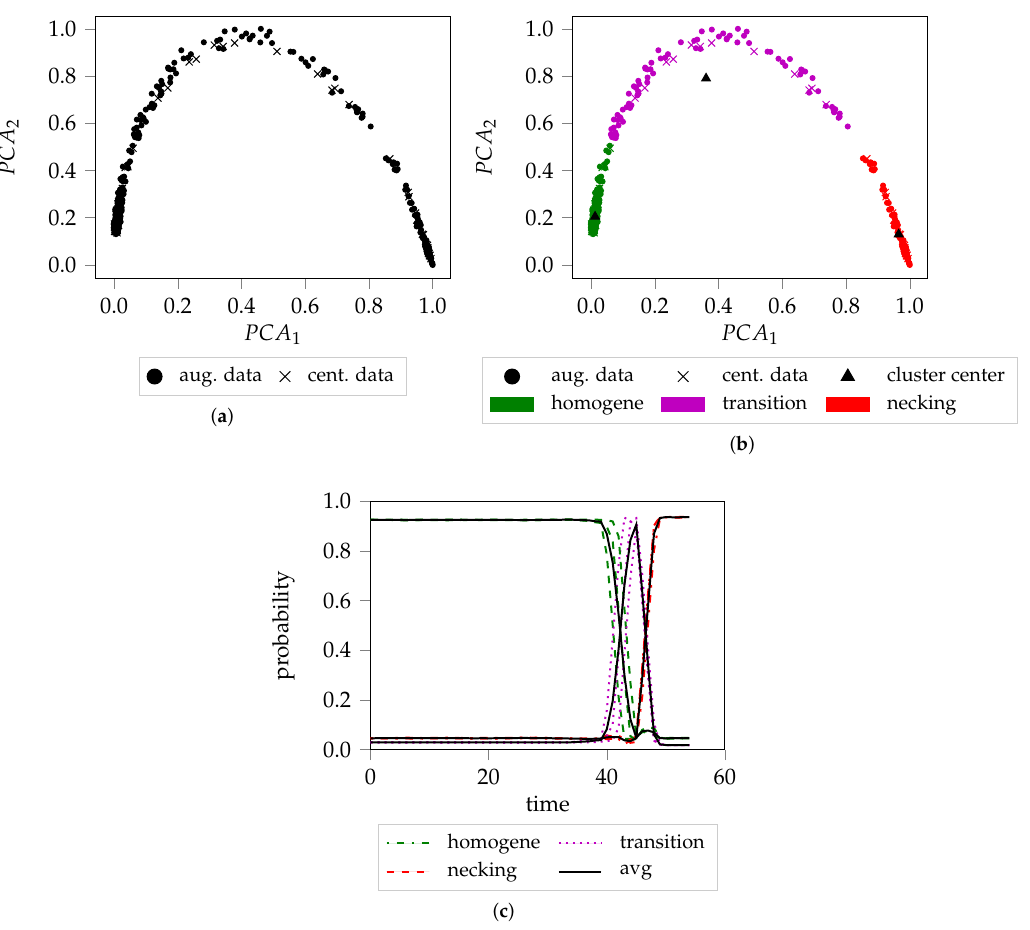
Figure 4. Exemplary procedure of the detection pipeline based on AA6014-S070: ( a ) Combined first two PCA components of the three forming sequences of AA6014-S070. ( b ) Same data as color coded cluster membership. ( c ) Cluster membership progression over time for each of the three sequences and their